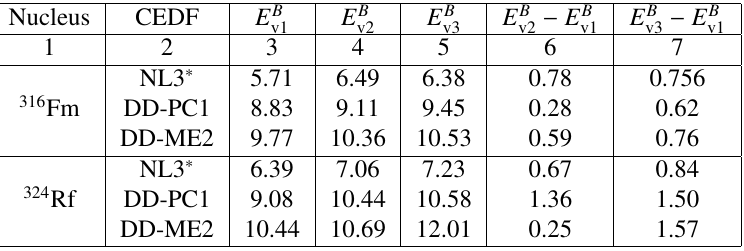
Table 2. Fission barriers heights E B [in MeV] for the indicated nuclei, functionals and versions of separable pairing. The columns 6 and 7 show the increases of fission barrier heights for two isospin dependent pairing interactions (v2 and v3) as compared to the one obtained with pairing of constant strength